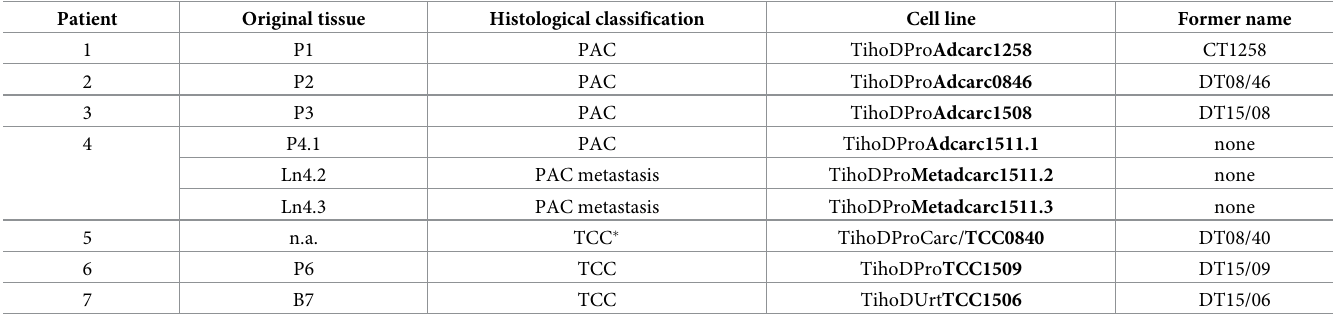
Table 1. Patients, tissue samples and cell